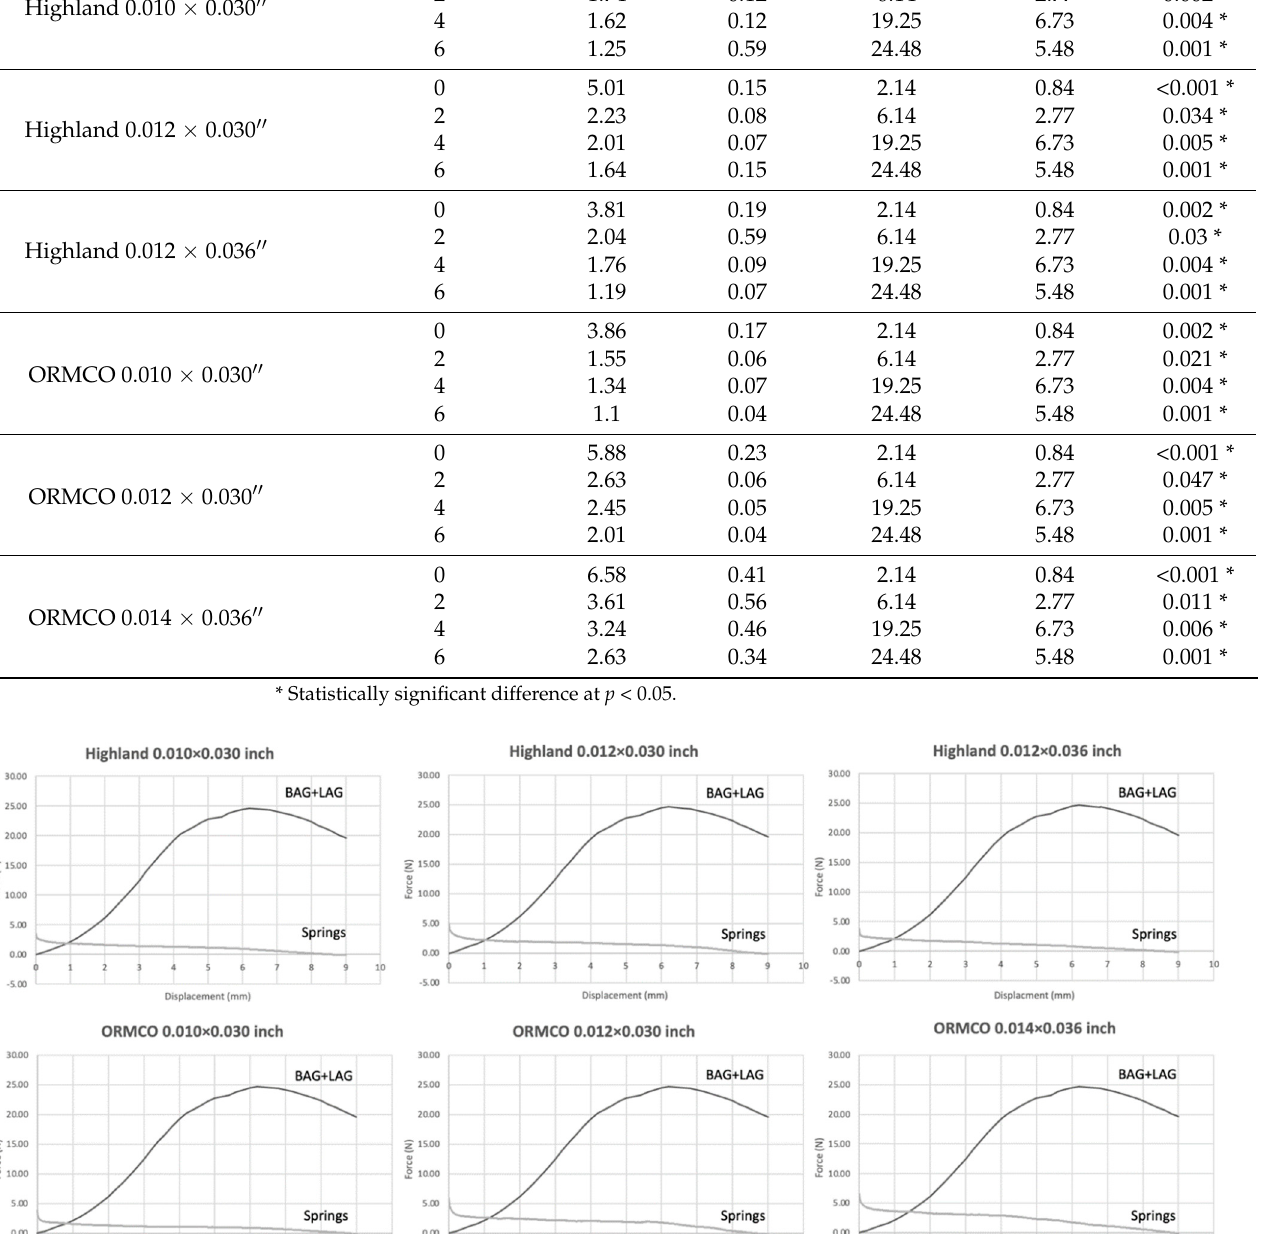
Table 4. Comparison of the mean load of tensile test between forces from NiTi springs tested in the distractor and forces from porcine attached gingiva.